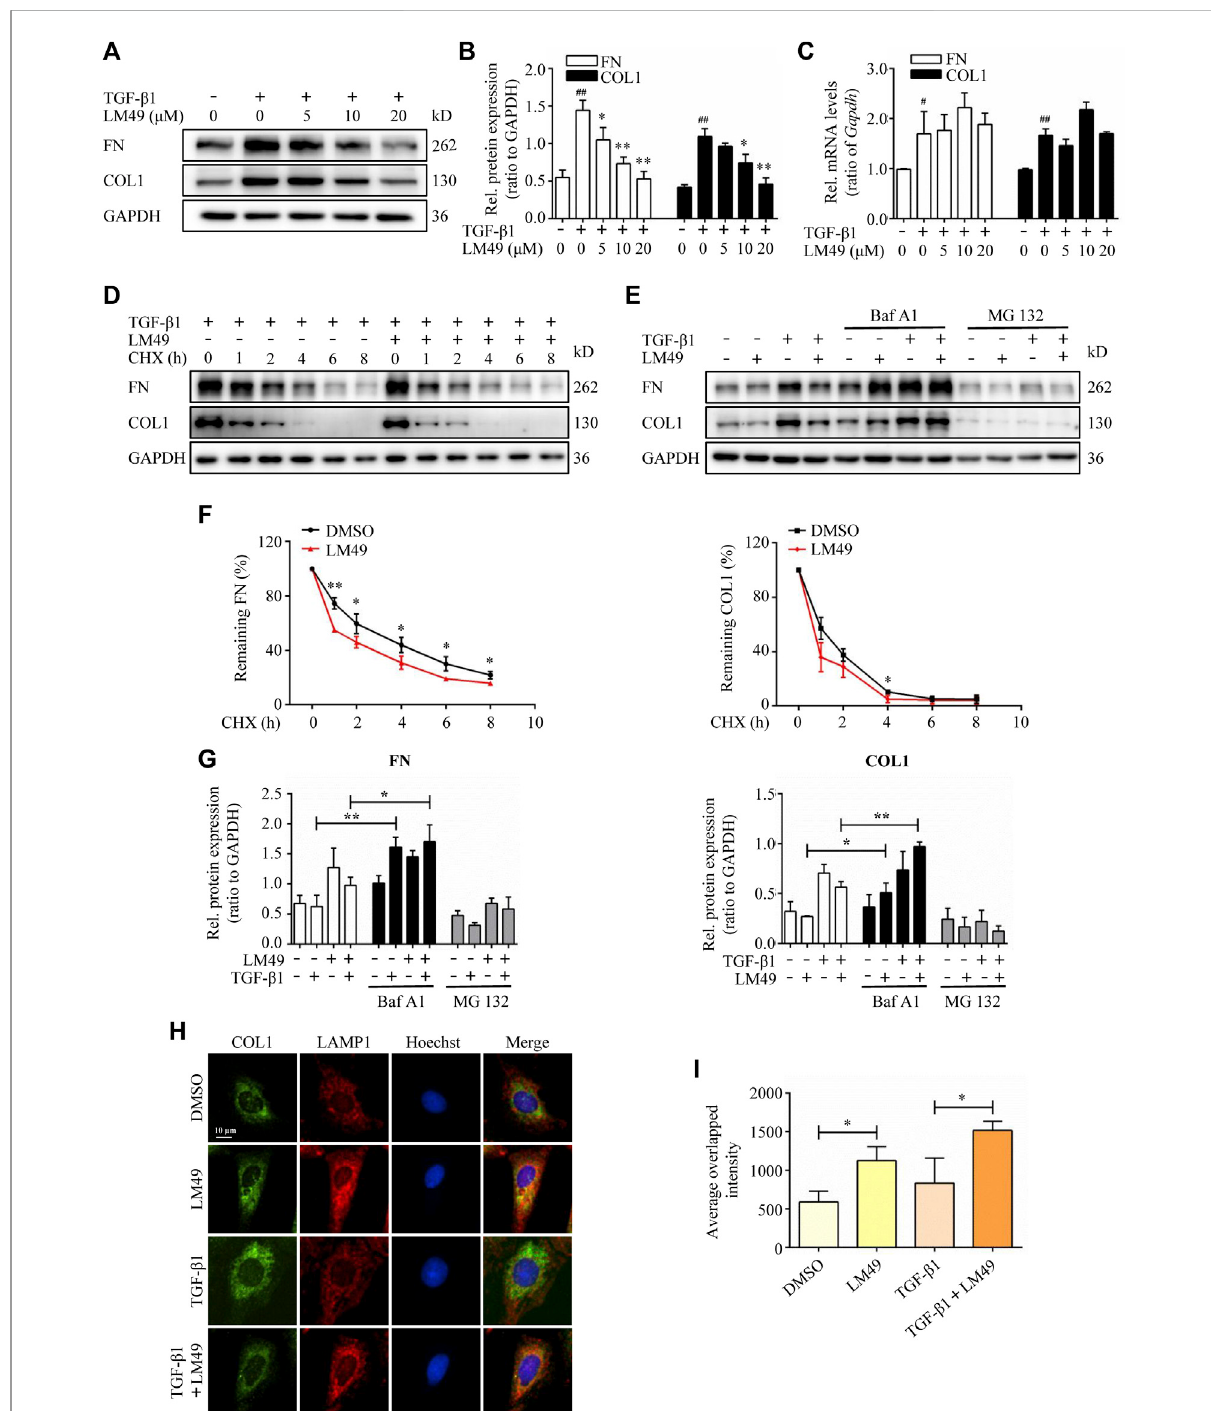
FIGURE 2 LM49 reduces TGF- β 1-induced ECM protein deposition in NRK49F cells through lysosomal protein degradation pathway. (A) Immunoblot analysis of the protein expression of FN and COL1 in NRK49F cells treated with indicated doses of LM49 and TGF- β 1 (5 ng/ml) for 24 h. (B) Quanti fi cationofFNandCOL1intensityin (A) . ## p < 0.01comparedwithDMSOgroup,* p < 0.05,** p < 0.01comparedwithTGF- β 1group(n=3). (C) QuantitativeRT-PCRanalysisofthemRNAlevelsofFNandCOL1inNRK49FcellstreatedwithindicateddosesofLM49andTGF- β 1(5 ng/ml)for 24 h # p < 0.05, ## p < 0.01 compared with DMSO group (n = 3). (D) Immunoblot analysis of the protein expression of FN and COL1 in NRK49F cells treated with DMSO or LM49 (20 μ M) in the presence of CHX (20 μ g/ml) and TGF- β 1 (5 ng/ml) for the indicated time points. (E) Immunoblot analysis of theprotein expression ofFN and COL1 inNRK49F cells treated with DMSO or LM49 (20 μ M) and BafA1 (10 nM) or MG132 (100 nm) in theabsence